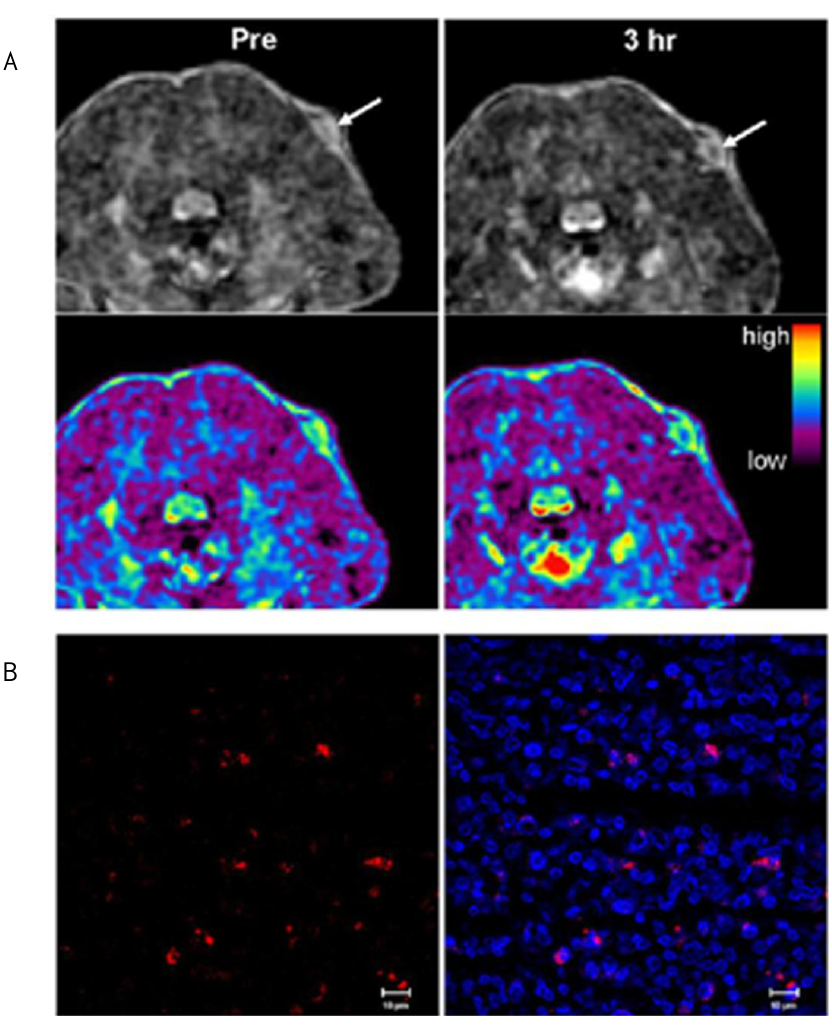
Figure 6. In vivo accumulation of iron oxide MSN at tumor site. (A) In vivo T MR images (upper) and color mapped (lower) images of tumor site before and 3 h after i.v. injection of iron oxide IO-MSN (arrows indicate tumor site); (B) LSCM of sectioned tumor tissue harvested 24h after injection. Left; red fluorescence showing IO-MSN internalized cells. Right; Merged image with DAPI stained nuclei (blue). Reproduced with permission from [52] ® 2010, American Chemical